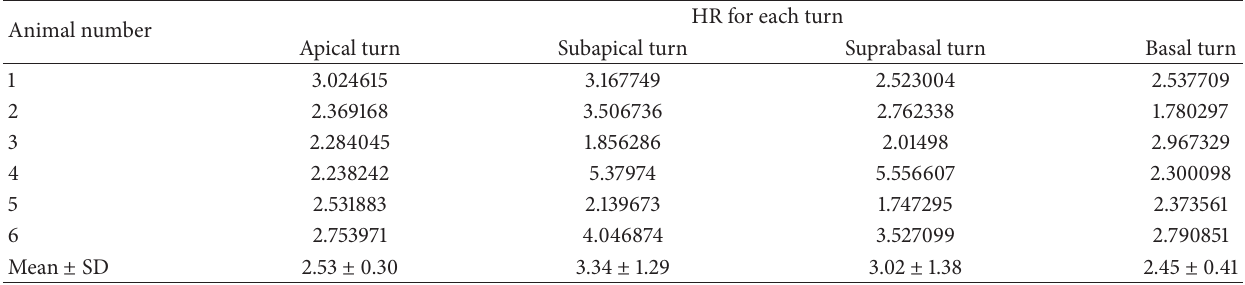
Figure 3: Mean HR value of each turn in the EH models. (a) HR was measured by the area of SM and SV. SM means the scala media, SV means scala vestibule, and ST means scala tympani. (b) Subapical turn had developed the most prominent hydrops with a mean HR value of 3.34, secondly followed by suprabasal turn. Mean HR values of all the turn are larger than 1 (dotted line: an indicator of no EH existence). Table 1: HR for each turn in the EH